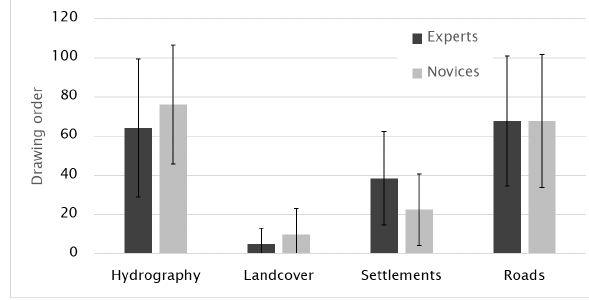
Figure 7. Scores for drawing order (Error bars indicate